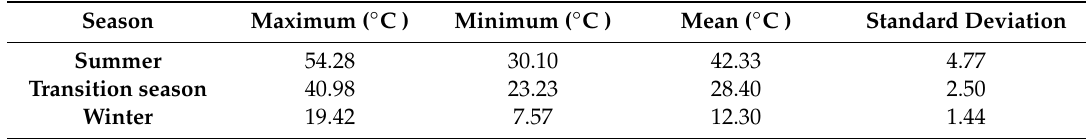
Table 2. The statistical summary of the retrieved LSTs for all seasons.